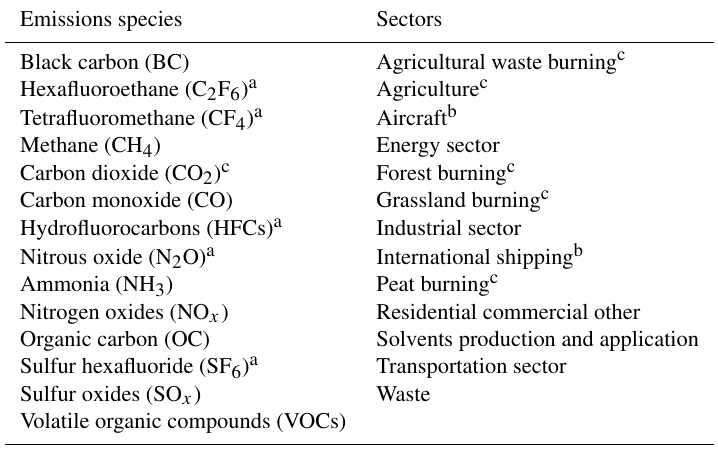
Table 2. Harmonized species and sectors, adapted from Gidden et al. (2018) with permission of the authors. A mapping of original model variables (i.e., outputs) to ScenarioMIP sectors is shown in Appendix Table B2.